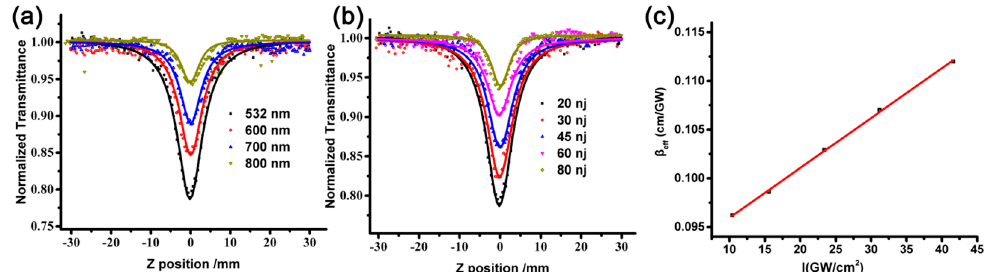
Figure 3. Femtosecond open aperture Z-scan data of PyDN under different wavelengths ( a ) and different incident laser energies at 532 nm ( b ); ( c ) incidental laser intensity dependence of efficient NLA coefficient. The different colored dots are the experimental data and solid lines represent the theoretical fitting.